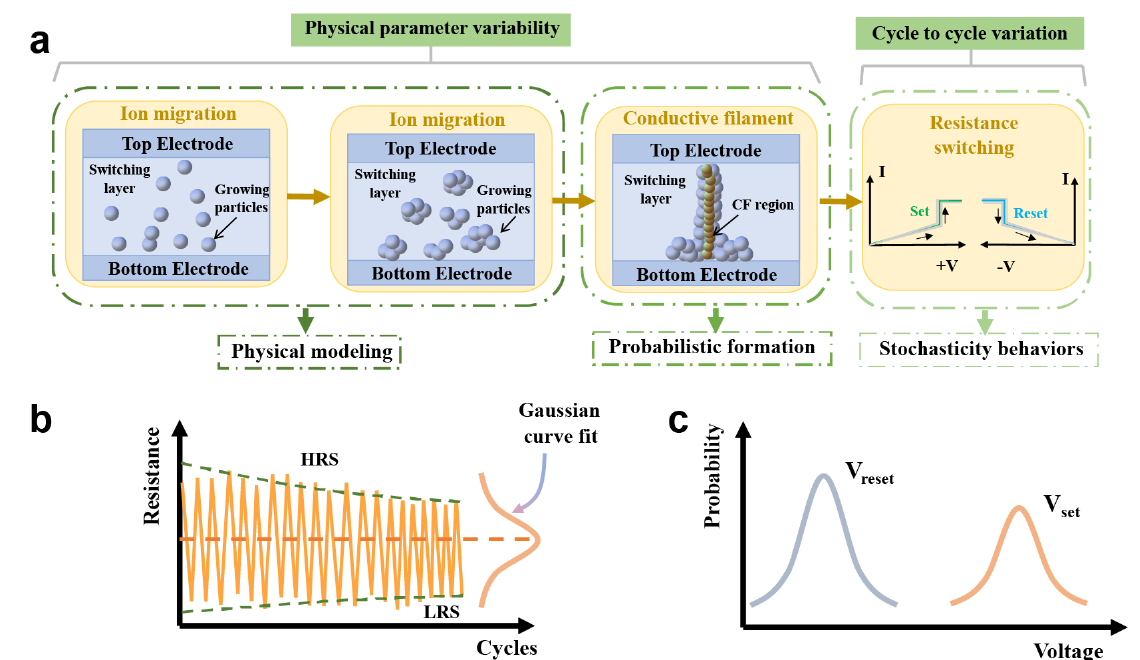
Figure 2. Resistive switching characteristics and oscillating electrical behaviors. ( a ) The memristor resistive switching model includes four stages: ion migration, accumulation, conduction channel formation, and resistance switching. The propagation of ions along the entire device size is random, and the growth of conductive filaments is also generated probabilistically, resulting in an oscillating behavior of resistive switching characteristics. ( b , c ) This inherent variation in the probabilistic formation and rupture of CF results in an oscillatory behavior of conductance ( b ) and threshold voltage ( c ) across cycles, which can be represented by a Gaussian distribution.